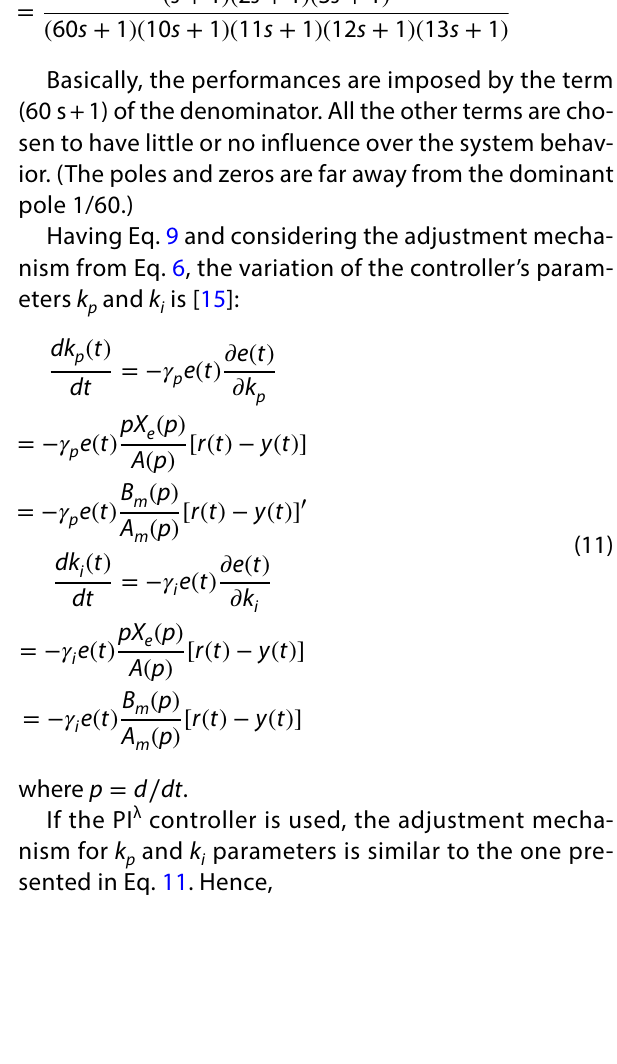
Fig. 3 The model reference adaptive control